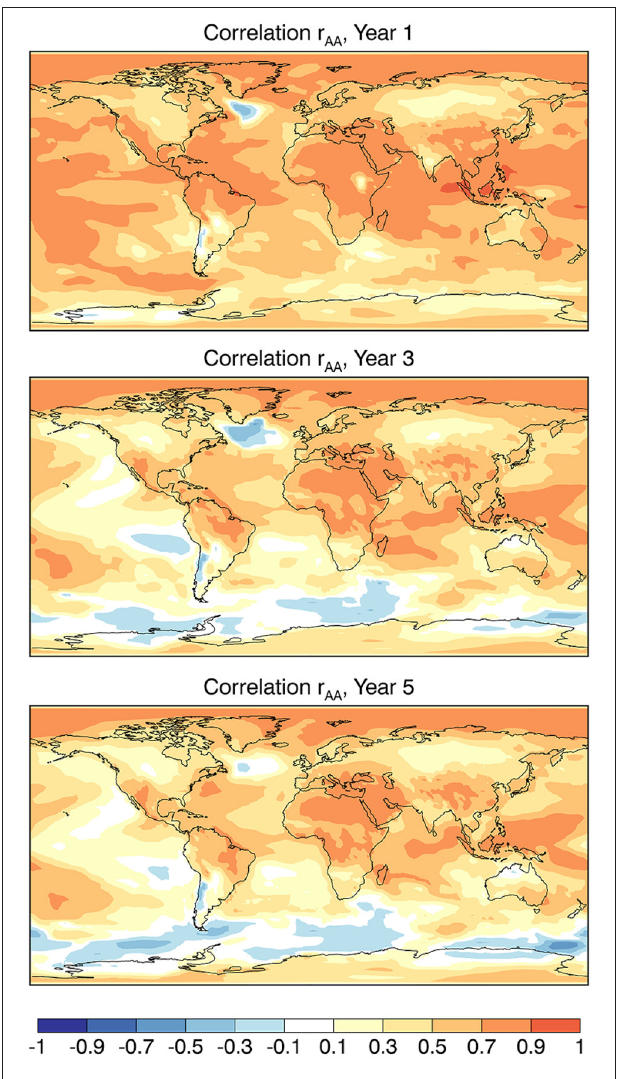
FIGURE 6 | Correlation skill r AA between the ensemble mean forecast and ensemble mean analysis.